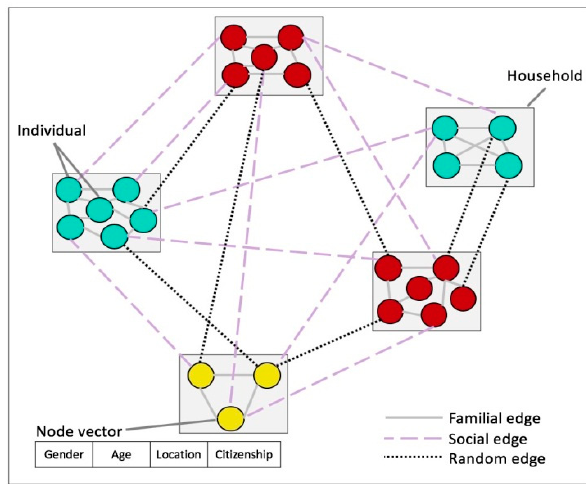
Figure 1. Schematic representation of the three edge types in the contact network.